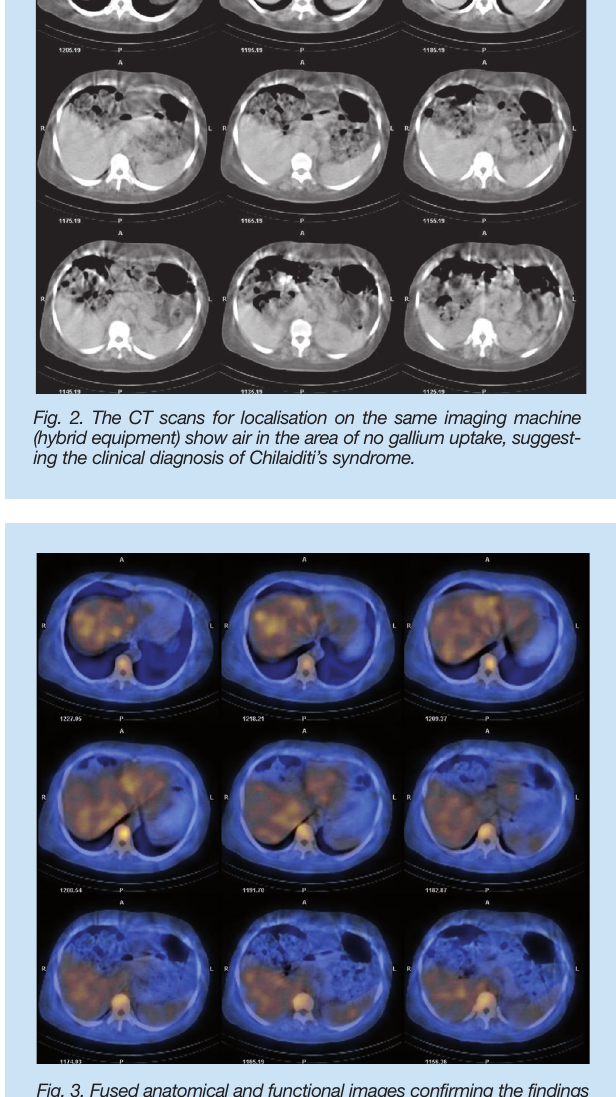
chilaiditti's.indd